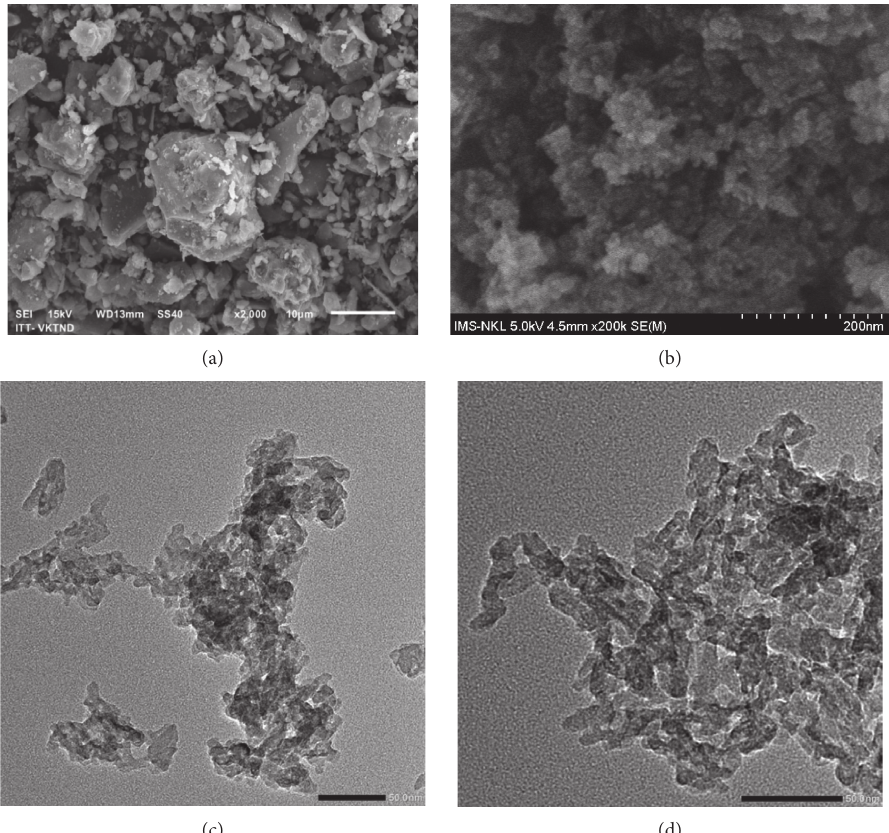
Figure 2: SEM images of apatite ore before (a) and after (b) modifying and TEM images of modified apatite ore (c, d).